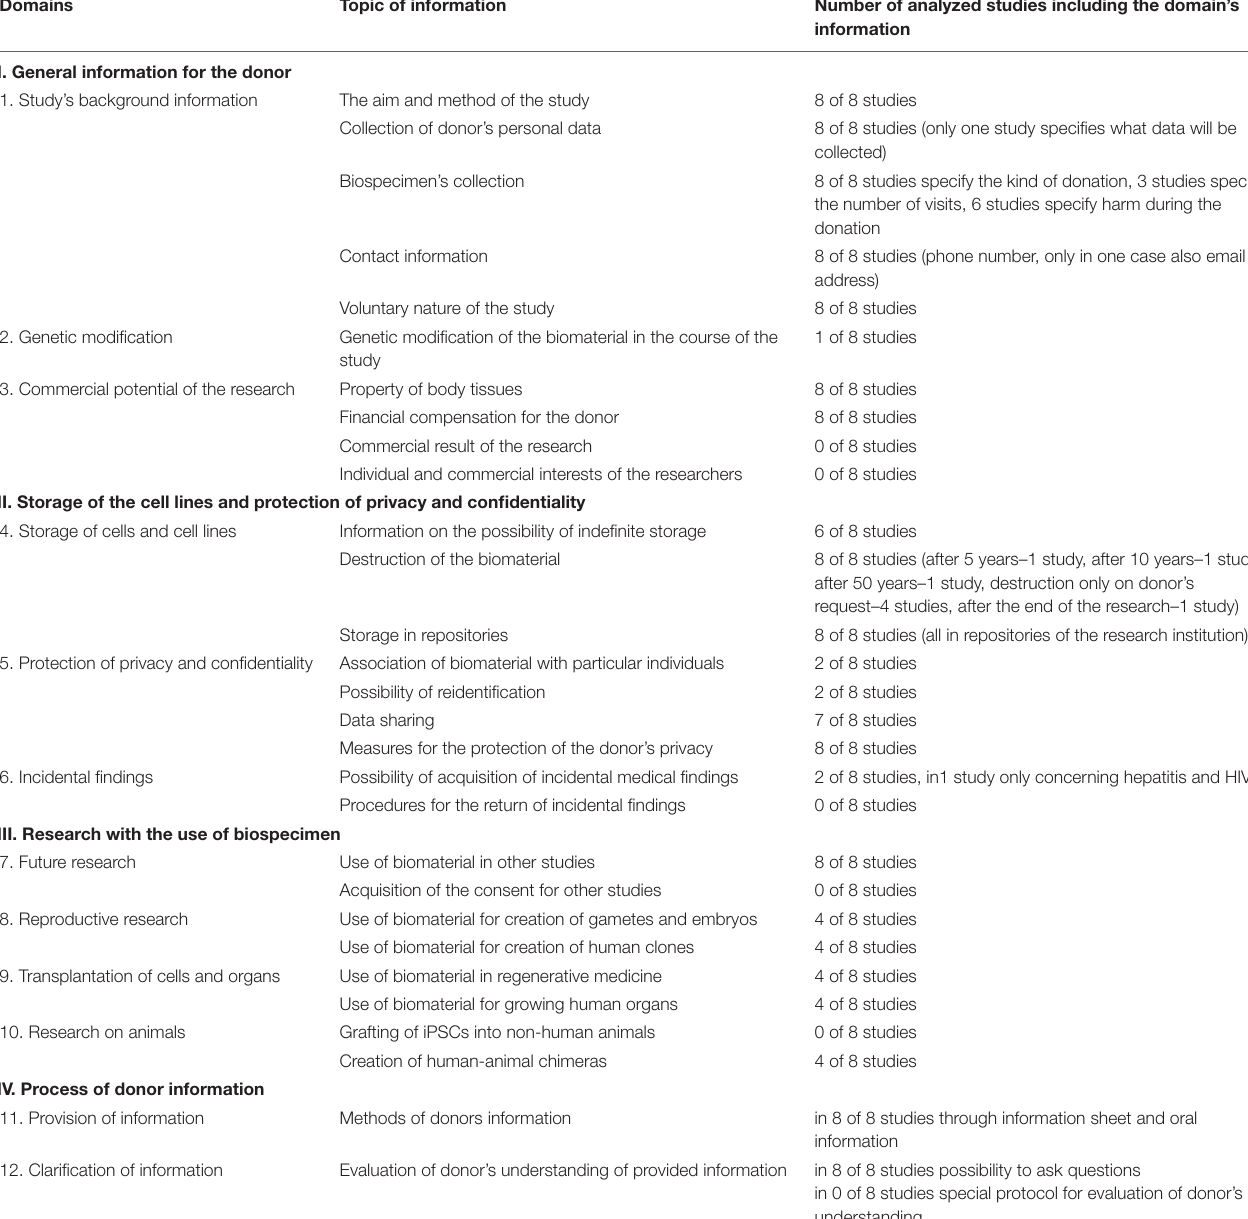
TABLE 1 | Domains of analysis of patient information in the identified